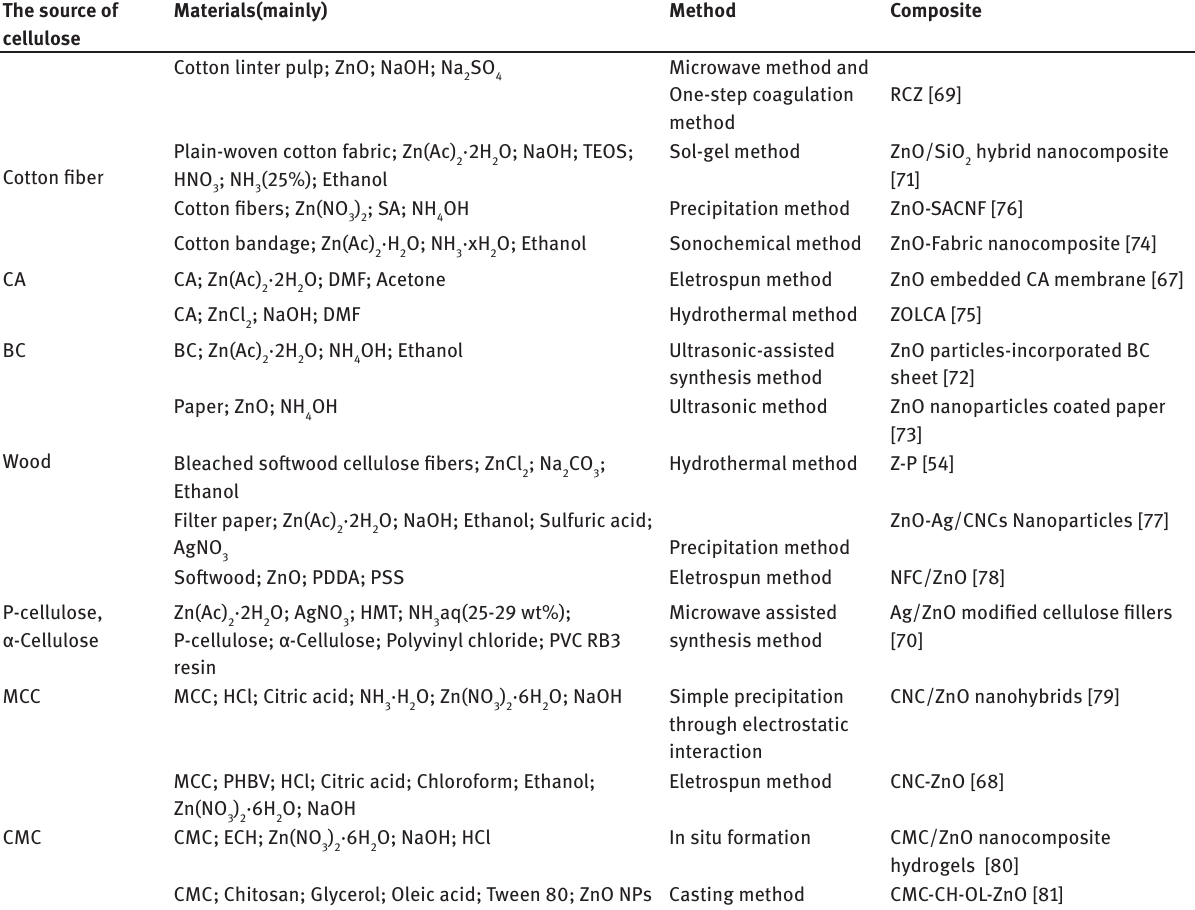
Table 1: The source of cellulose, materials and method of synthesis. The source of cellulose